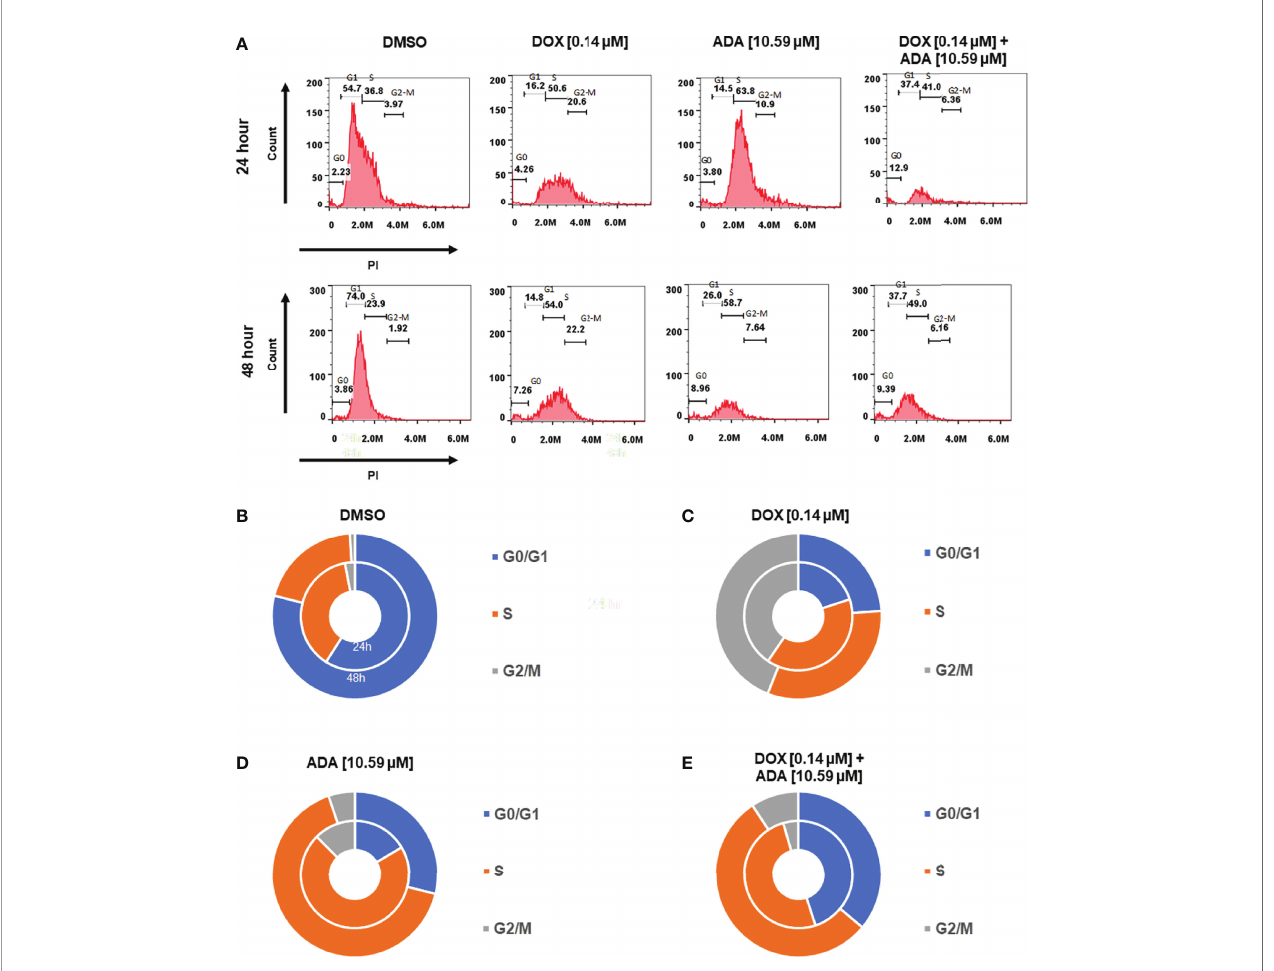
FIGURE 7 | Doxorubicin and adapalene induce cell cycle arrest of MDA-MB-231 cells. (A – E) ADA upon treatment showed S-phase arrest of MDA-MB-231 cells, while DOX showed the arrest of MDA-MB-231 cells in the G2/M phase of the cell cycle. Upon Combination treatment with DOX and ADA, the arrest of cells enhanced in the